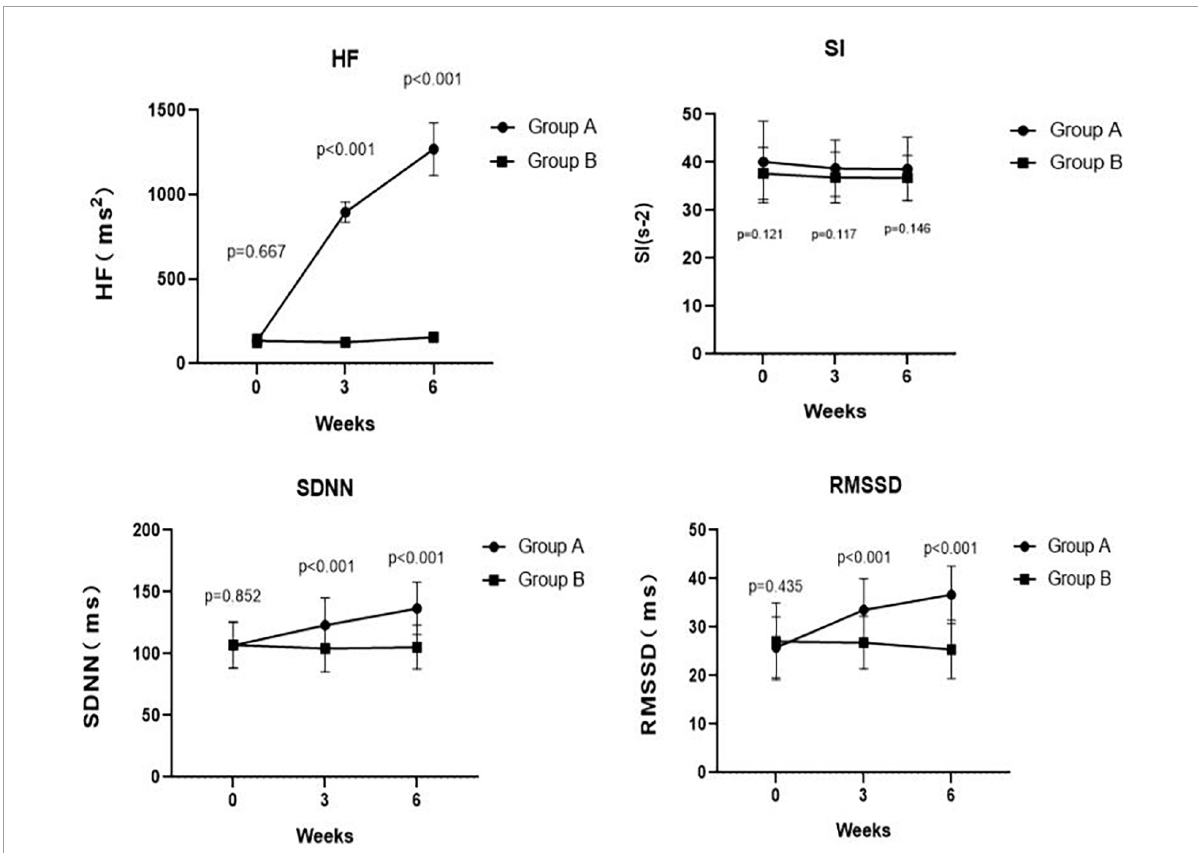
FIGURE4 Comparing traditional or corrected HF, SI, SDNN, and RMSSD pre- and post-treatment at weeks 3, 6 between Groups A and B. The corrected HF in Group A was significantly higher than the HF in Group B at week 3 ( p < 0.001) and at week 6 ( p < 0.001). There was no significant difference in SI between Group A and Group B at week 3 ( p = 0.117) and at week 6 ( p = 0.146). At weeks 3, 6, the SDNN in Group A was significantly higher than that in Group B ( p < 0.001 and p < 0.001, respectively). Meanwhile, at weeks 3, 6, the RMSSD in Group A was significantly higher than that in Group B ( p < 0.001 and p < 0.001,